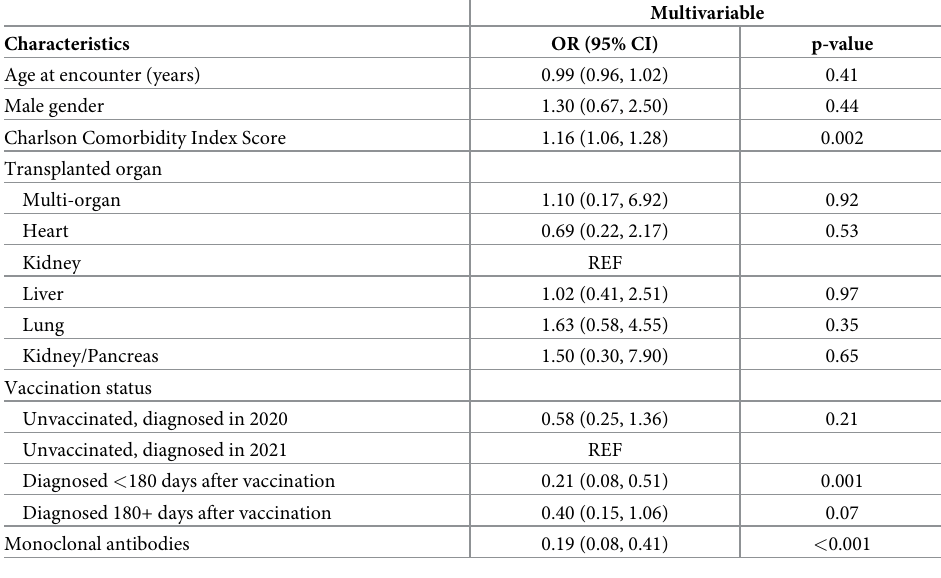
Table 6. Risk of ICU admission among solid organ transplant recipients diagnosed with COVID-19, in the pro- pensity score matched cohort (N = 282).